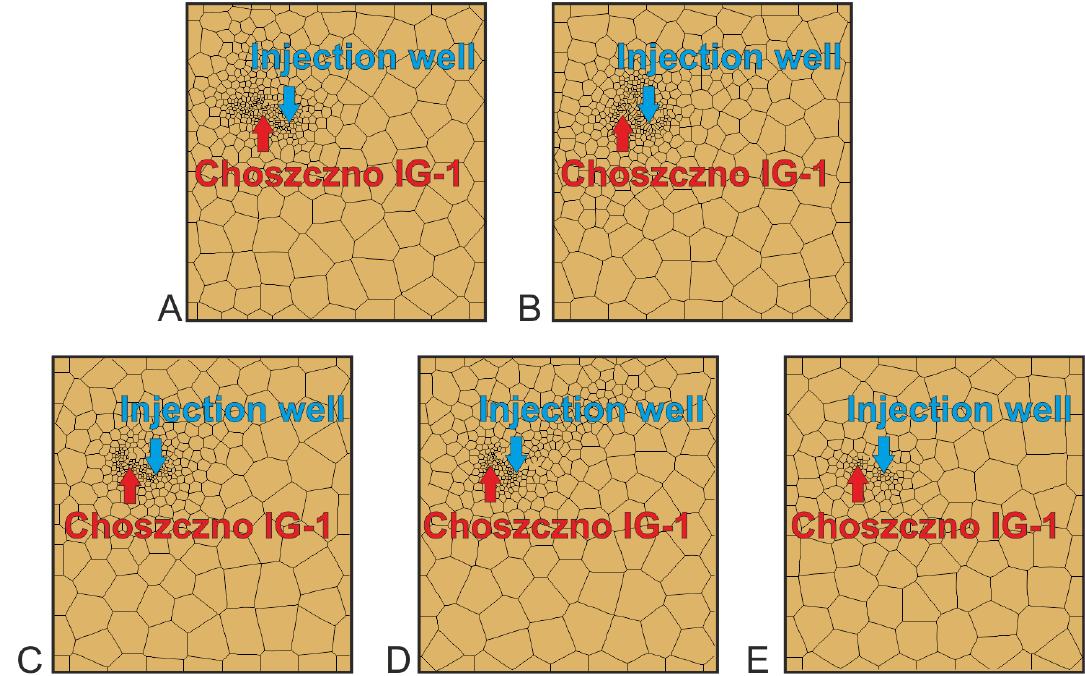
Figure 5. Variants of calculation grid density calculation. Areas of grid blocks: A–1 m 2 , B–10 m 2 , C– 100 m 2 , D–1000 m 2 , E–10,000 m